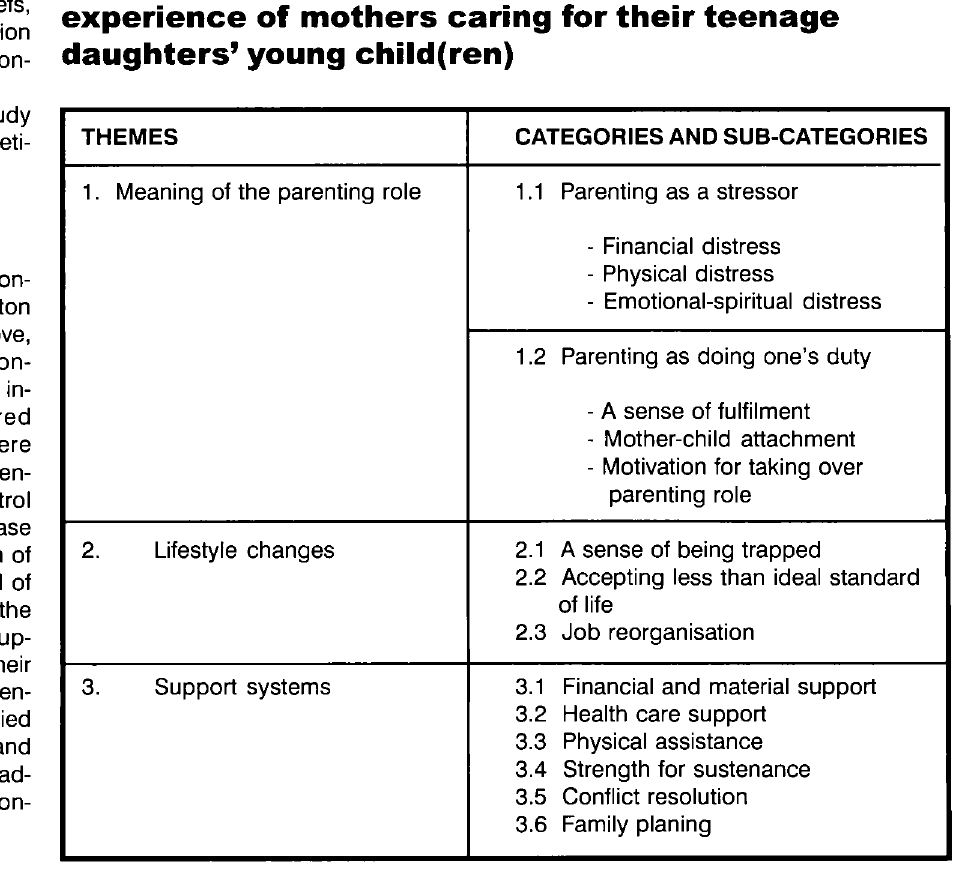
Table 2 : An overview of themes and categories